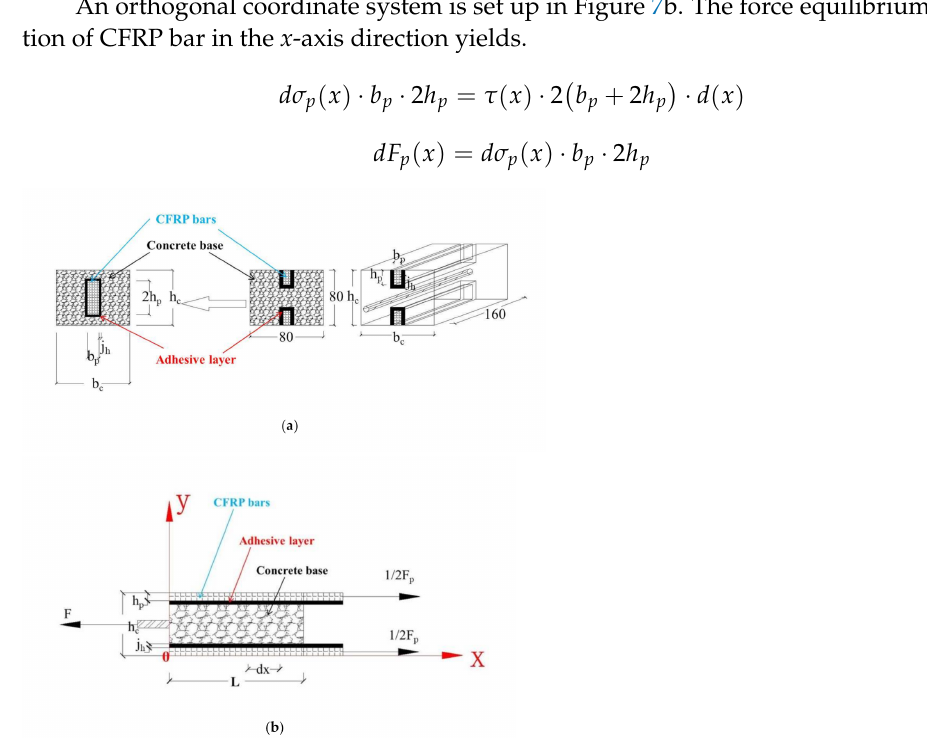
Figure 7. Interface bond model: ( a ) Mechanical equivalent model; ( b ) Boundary conditions